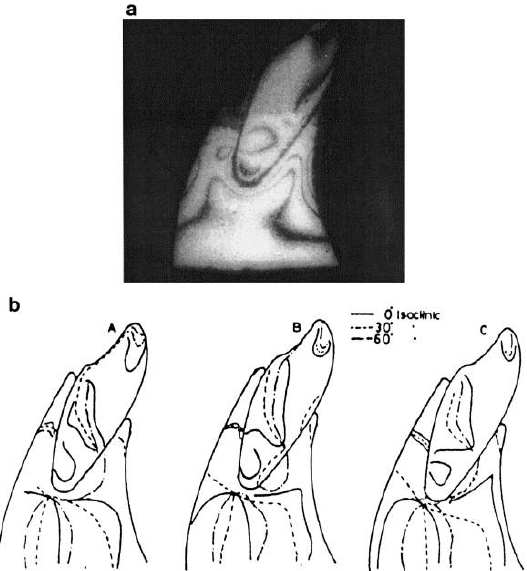
Figure 6. ( a ) Fringe pattern showing stress distribution in a tooth with normal supporting bone at a load of 225 N along its long axis. ( b ) Fringe patterns showing stress distribution when load is directed at ( A ) 0 ◦ ( B ) 30 ◦ and ( C ) 60 ◦ to the long axis. Strain gauge and photoelastic analysis of in vivo strain and in vitro stress distribution in human dental supporting structures. Adapted with permission from Ref. [92]. 2019,